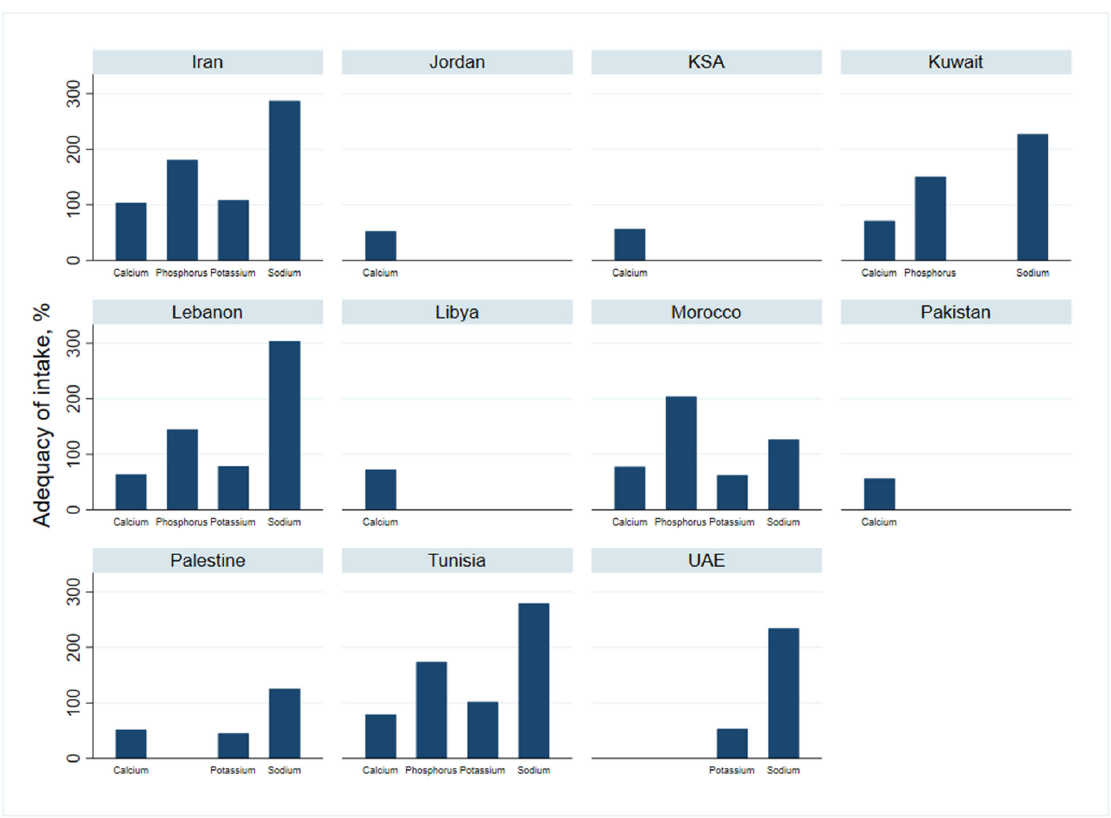
Figure 2 . Adequacy of minerals intake for people in the countries sampled in the Eastern Mediterranean Region.